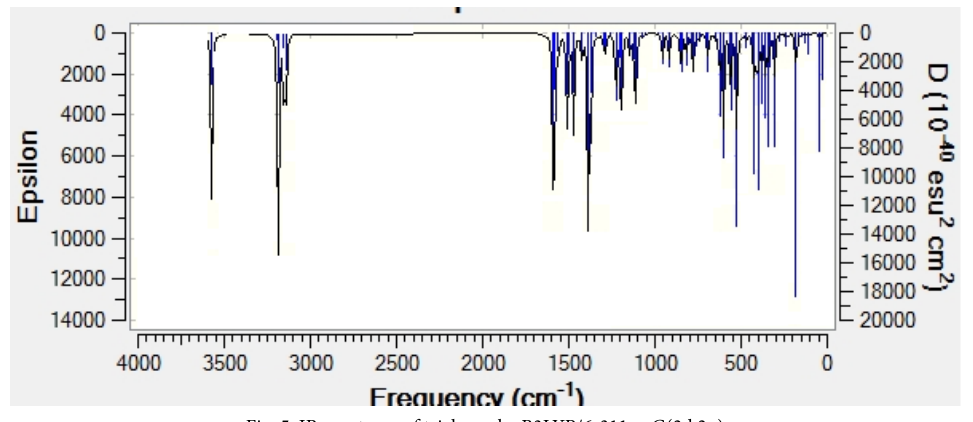
Fig 4. NBO contribution of triclosan electron by B3LYP/6-311++G(2d,2p)